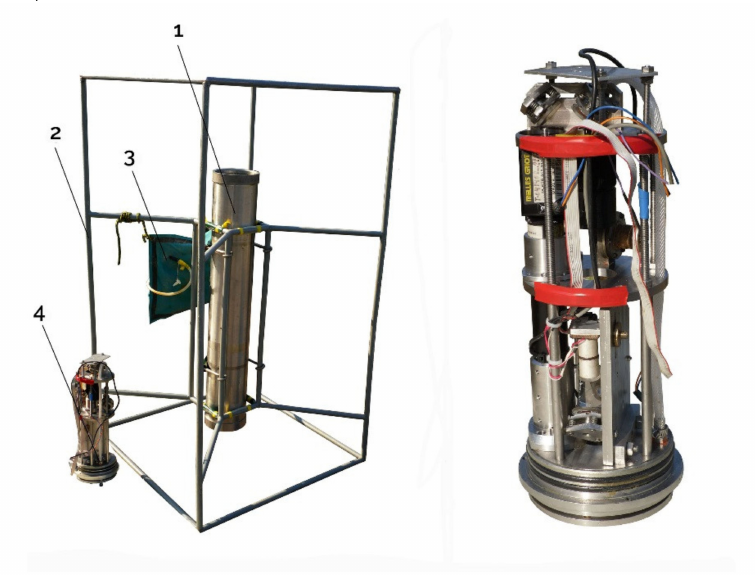
Figure 2. Photo of the laser meter of hydrosphere pressure variations records. (1)—stainless-steel housing, (2)—protective grill, (3)—air container, (4)—laser meter of hydrosphere pressure in the small